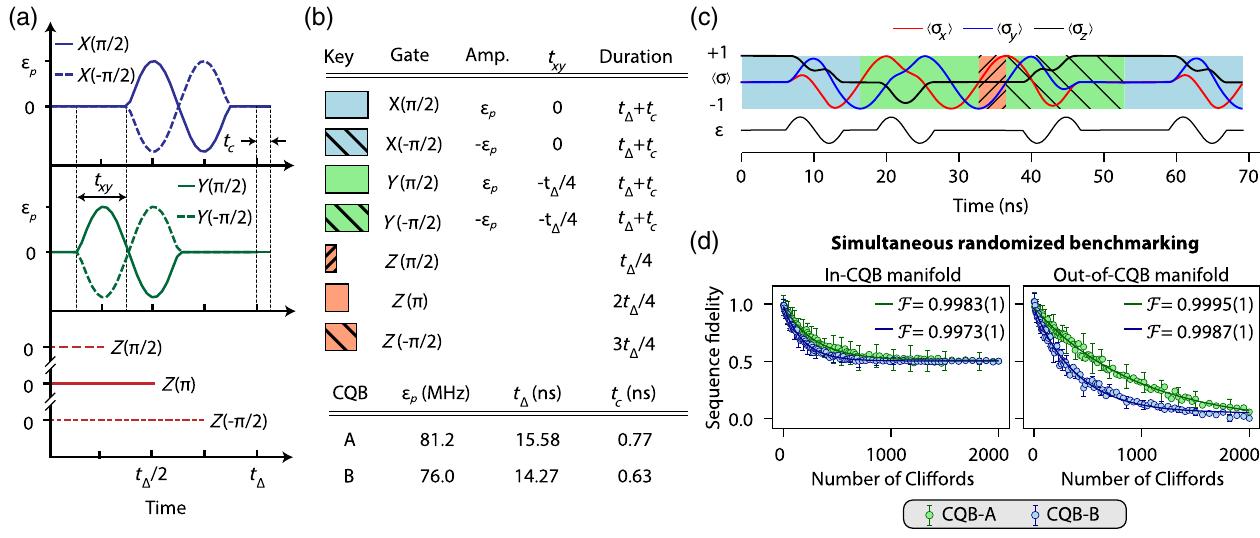
FIG. 2. Single-CQB gates. (a) Pulses for X , Y , and Z gates. For X ð(cid:3) π = 2 Þ and Y ð(cid:3) π = 2 Þ gates, the sinusoidal pulse is applied within a t Δ = 4 ¼ 2 π = 4 Δ , which establishes the x and y axes. The X ð(cid:3) π = 2 Þ and Y ð(cid:3) π = 2 Þ gates require an time window with a relative shift t xy ¼ additional Z rotation of duration t that corrects for small parasitic Z evolution during the gate. The Z gates are realized by idling at the c avoided crossing for the appropriate fraction of the precession period 1 =t Δ . (b) Table of parameters ε and Z gates, and the calibrated values for CQB-A and CQB-B. (c) Examples of concatenated gates and simulations of the resulting Bloch vector projections on h σ , h σ , and h σ . (d) Simultaneous randomized benchmarking traces corresponding to Clifford fidelity x i y i z i (errors within the computational subspace) and leakage Clifford fidelity (errors that leave the computational